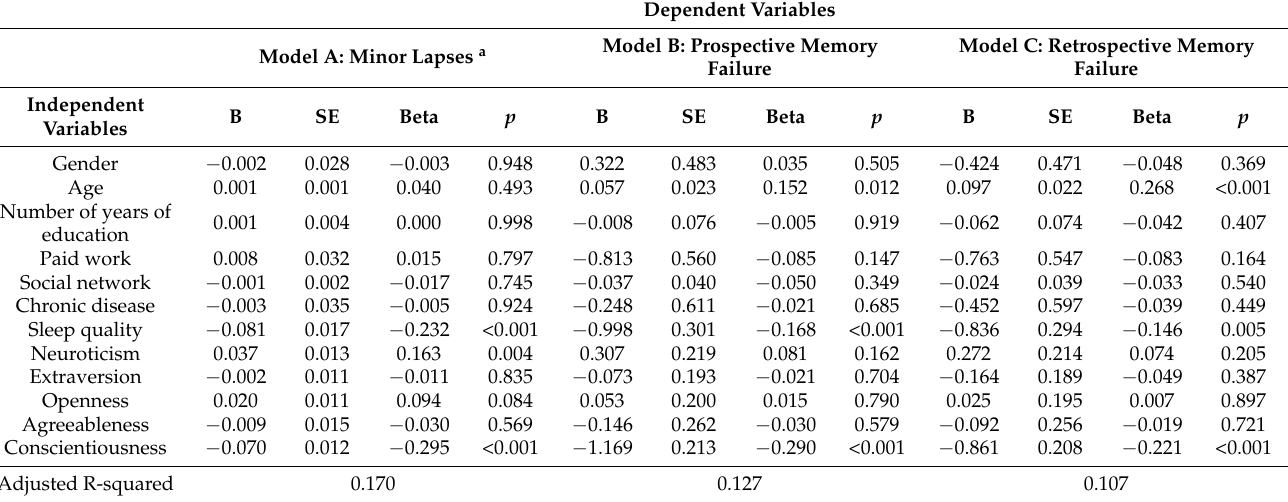
Table 3. Association between personality traits and cognitive failures (multivariable regression analyses) (N =